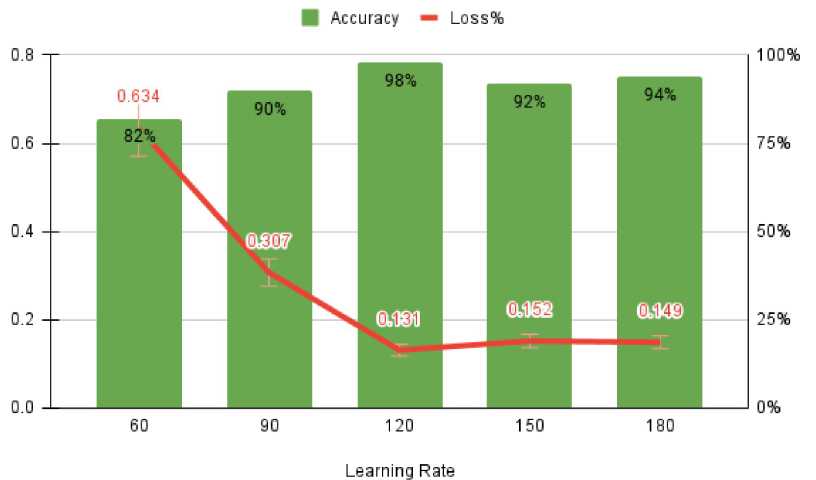
Fig 15. Accuracy as the function of iteration.